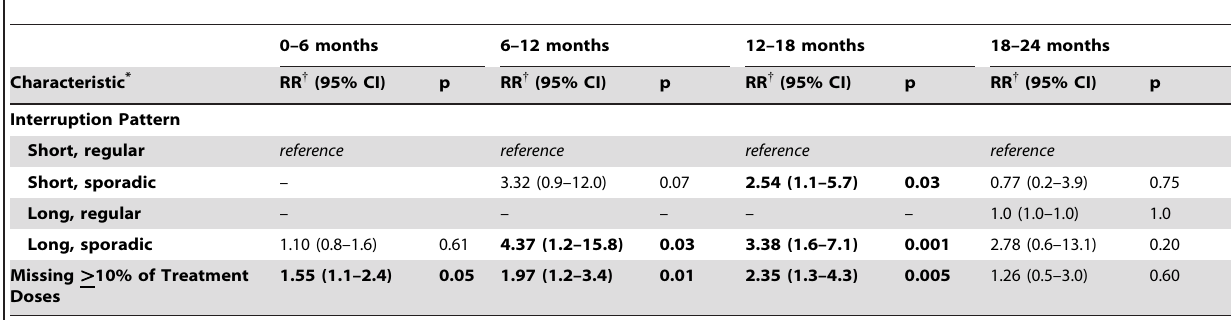
Table 4. Multivariate association between treatment interruption pattern characteristics for each 6 month treatment period and poor treatment outcomes (default, failure, death) among MDR TB patients with at least one missed dose during the course of treatment